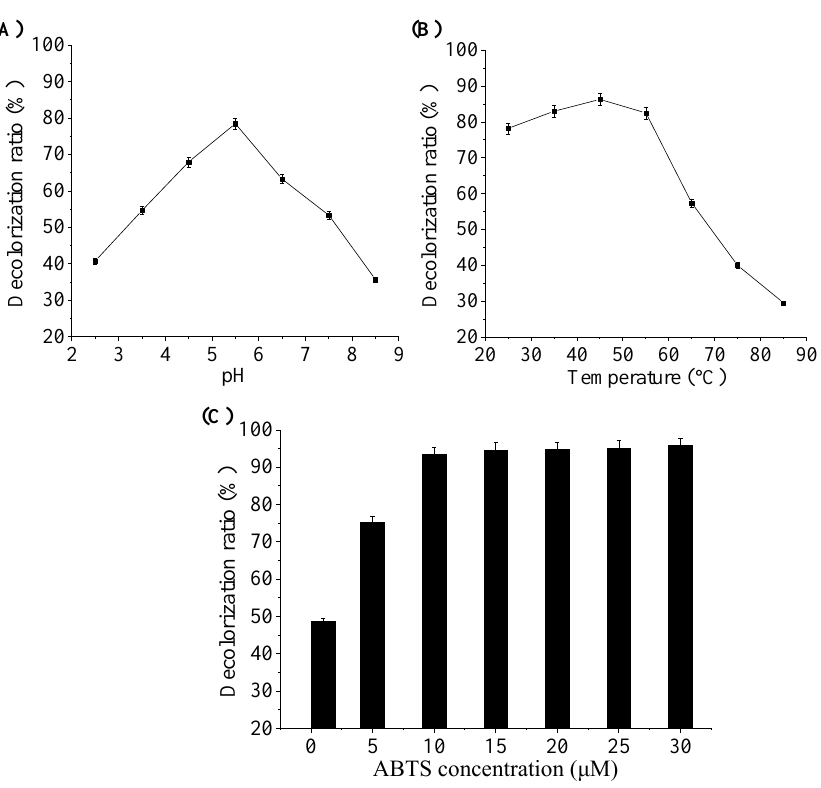
Figure 5. Effects of different parameters on MR decolorization in an ABTS-laccase mediated system: ( A ) pH; ( B ) Temperature; ( C ) ABTS concentration. Data were expressed as mean ± SD (n = 3).